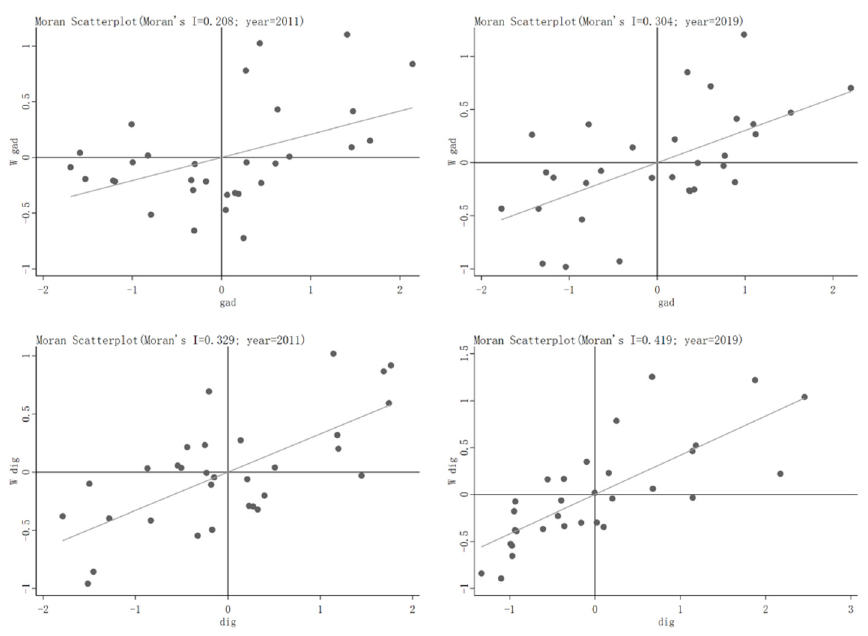
Figure 1. Local Moran’s I index of digital inclusive finance and agricultural green development.